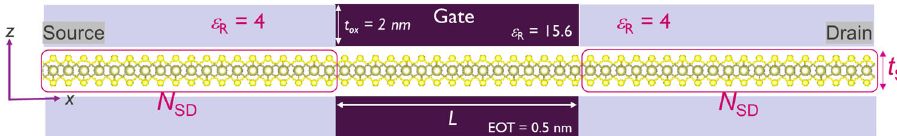
Fig. 1 Schematic view of a double-gate MOSFET, where the channel is made of one of the monolayer 2D materials studied here. The doped contact, oxides (gate and spacer regions), as well as the main device parameters, are shown on the fi gure. The atomic structure that is depicted in this fi gure is that of a TMD, here it is HfS 2 , with the metallic atom (Hf) in the center, sandwiched between the two chalcogen (S) atoms at the top and bottom.